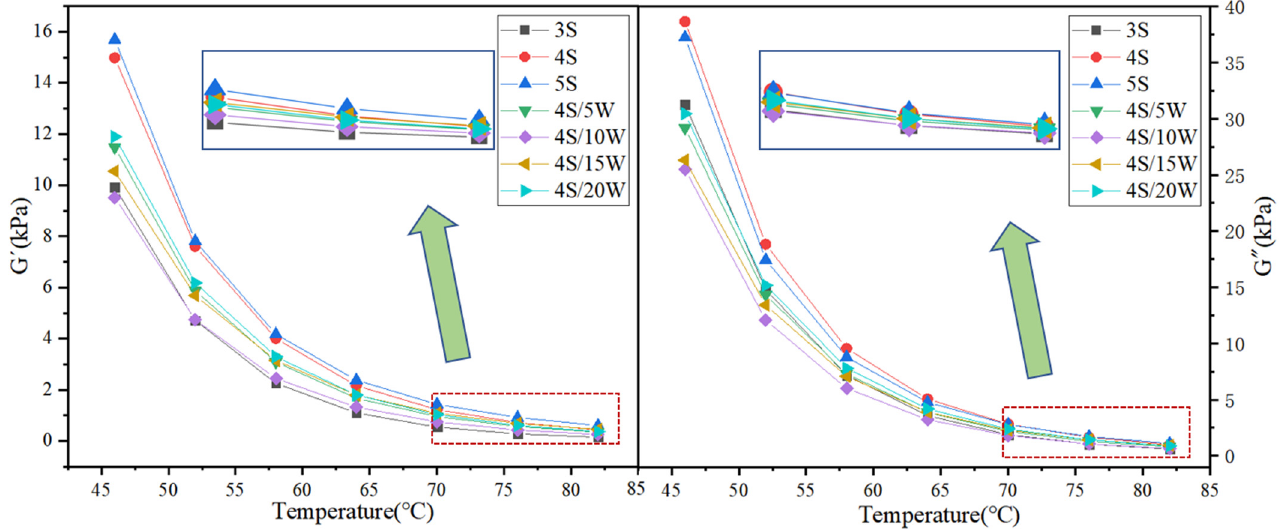
Figure 5. G’ and G” of WPU/SBS composite modified asphalt.